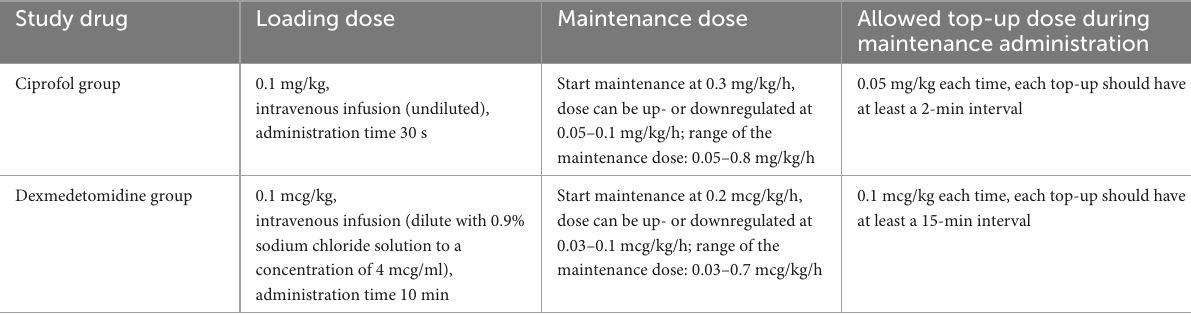
TABLE 1 Administration of the study drug. Study